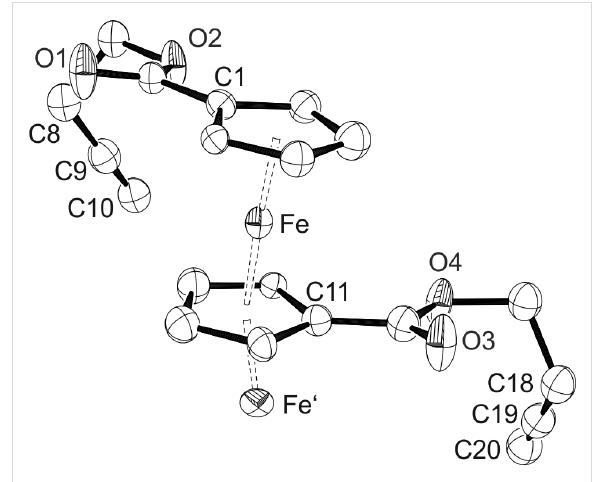
Figure 3: ORTEP diagram of 1a with thermal displacement parame- ters drawn at 50% probability; hydrogen atoms are omitted for clarity; occupation Fe 74%, Fe’ 26%. Selected bond lengths [Å] and angles [°]: Fe–Ct1 1.6947(12), Fe-Ct11 1.6695(12), Ct1-Fe-Ct11 176.96(8), C9–C10 1.186(11), C8–C9–C10 177.2(9), C19–C20 1.165(12), C18–C19–C20 178.1(10).